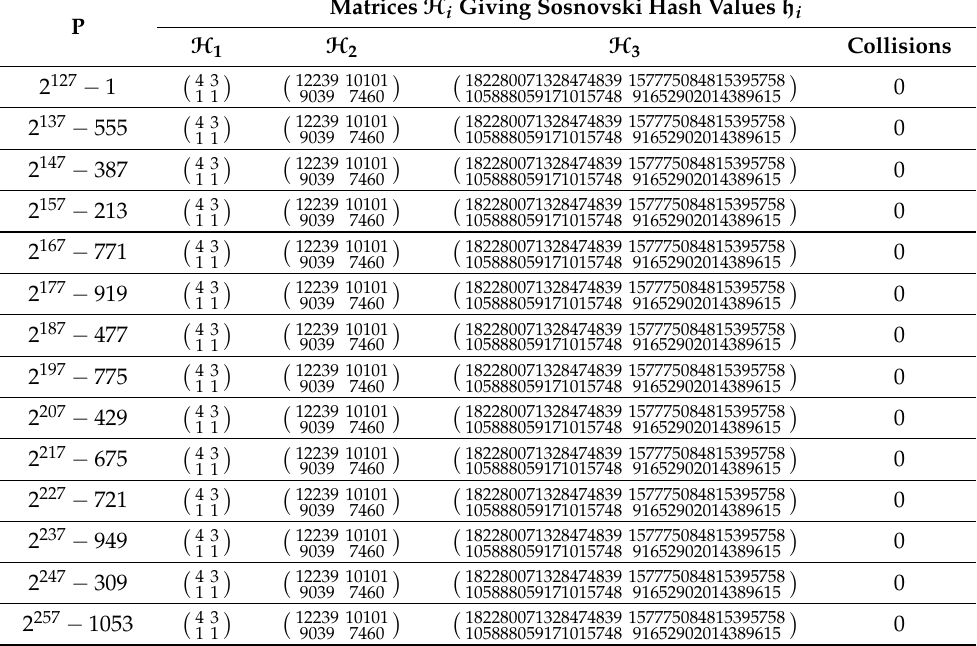
3 are used to compute hash values h i (see Algorithm 4). i ≤ ≤